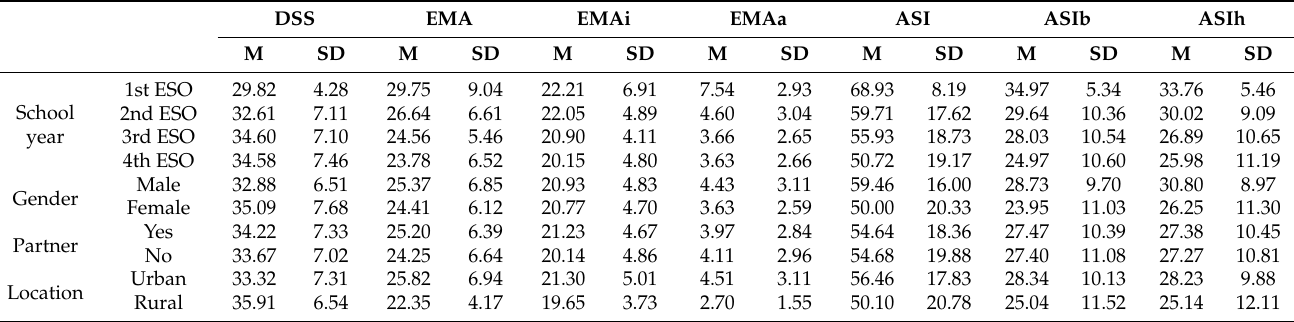
Table 3. Mean scores and standard deviations for each scale, according to academic year, gender, relationship status and